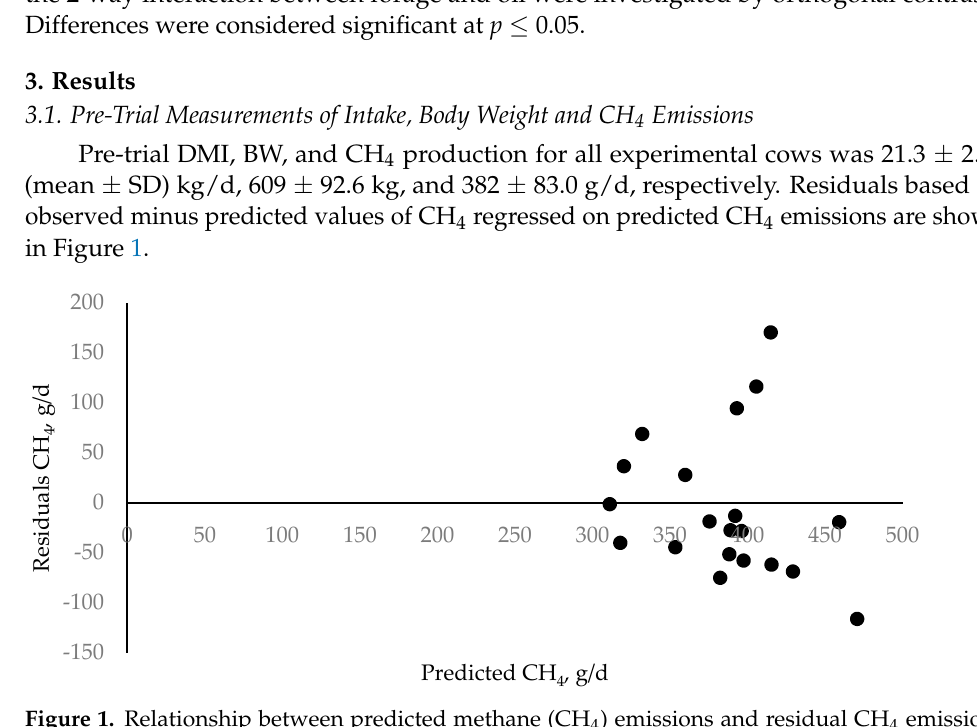
Figure 1. Relationship between predicted methane (CH 4 ) emissions and residual CH 4 emissions (CH 4 observed − CH 4 predicted) ( n = 20).